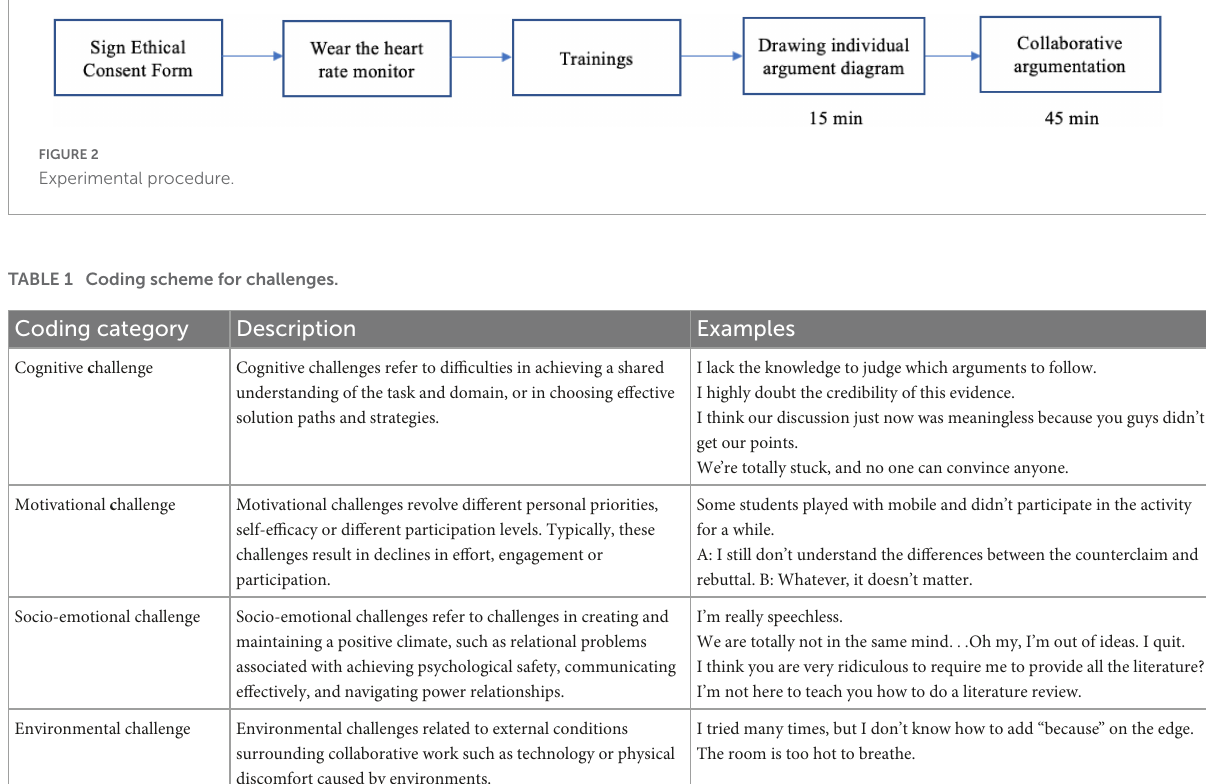
FIGURE1 Group argument diagram.